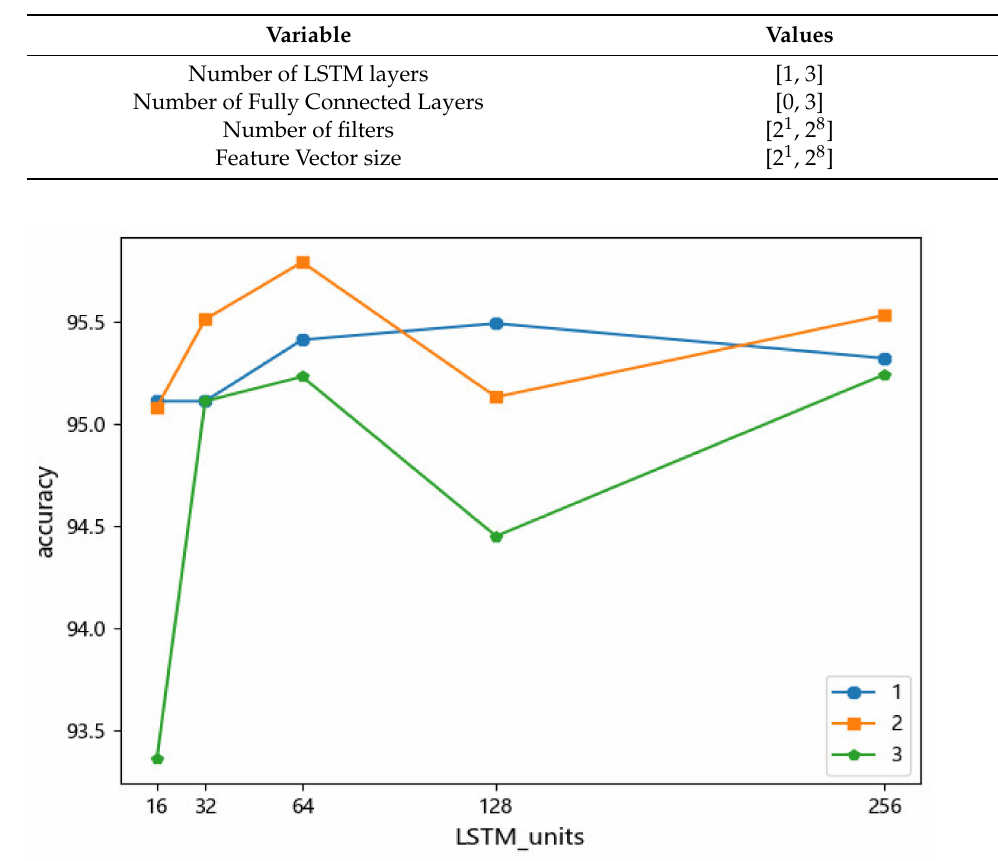
Figure 8. Accuracy with different LSTM units and layers. LSTM_units represent the number of LSTM units and curves of different colors represent different